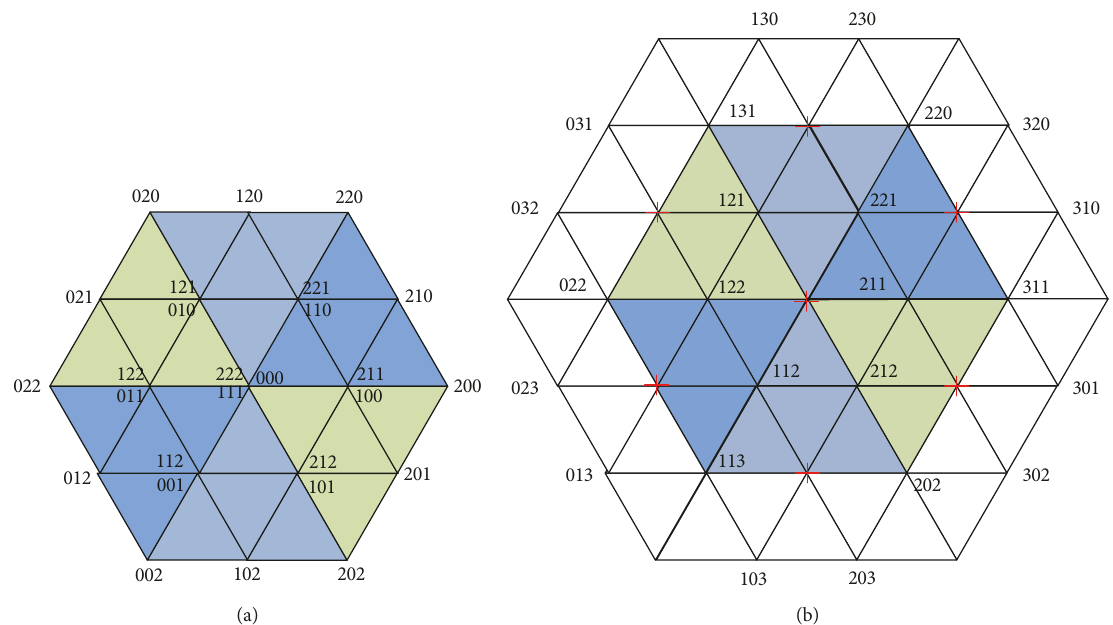
Figure 3: Space vector diagram (a) three-level inverter and (b) four-level inverter v